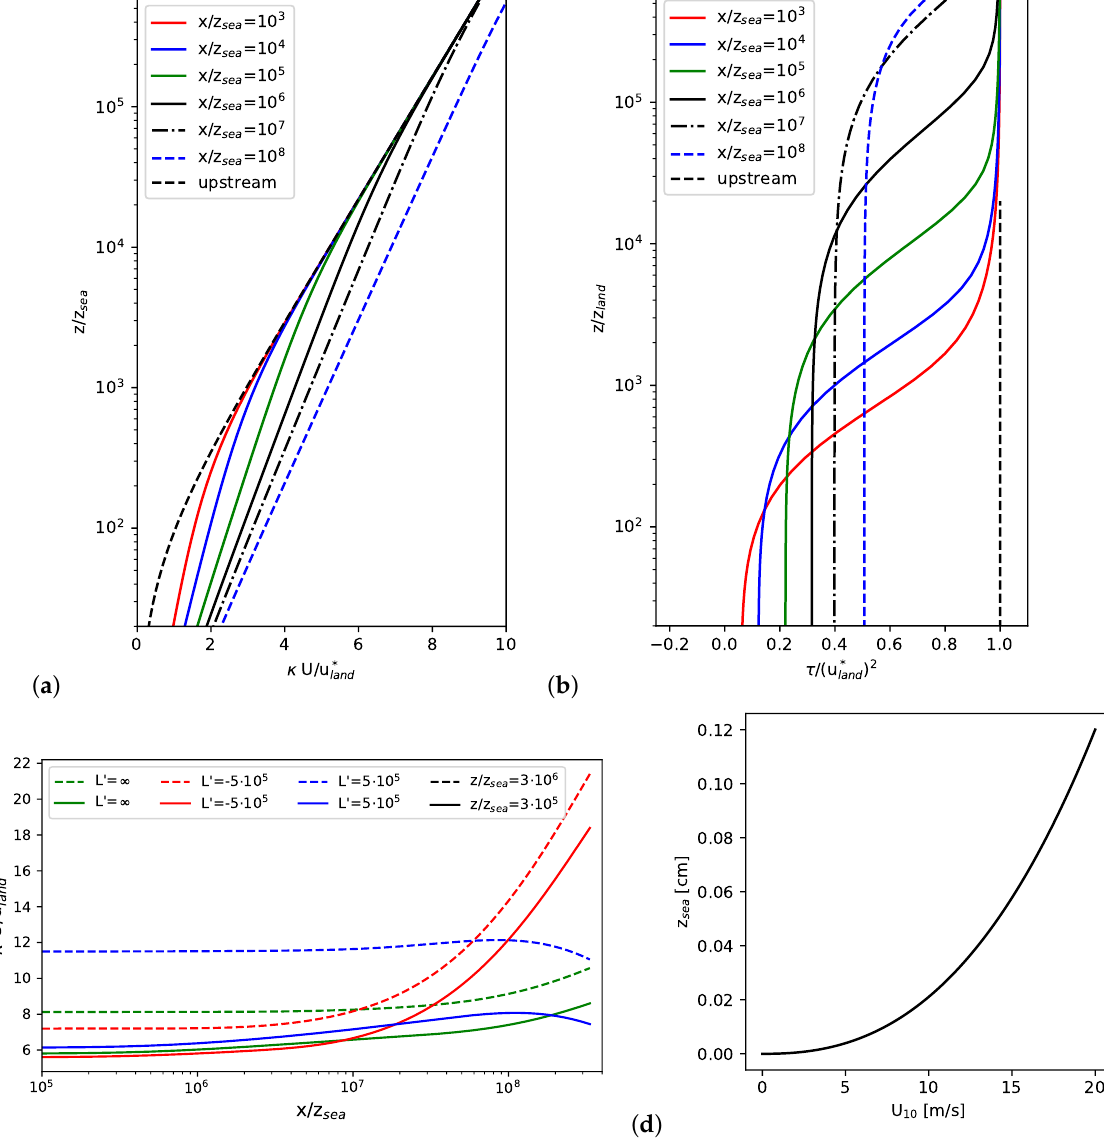
Figure 3. ( a ) Profiles of normalised wind speeds with z land /z sea =55 at different normalised down- stream distances for neutral conditions. ( b ) Associated normalised stress profiles. ( c ) Downstream transects of normalised wind speeds at two normalised heights z/z sea = 10 5 (solid lines) and z/z sea = 10 6 (dashed lines). Colors refer to different stabilities of the boundary layer with neu- tral in green, stable in blue and unstable in red. ( d ) Sea surface roughness length as a function of 10 m wind speed for a fully developed sea state according to